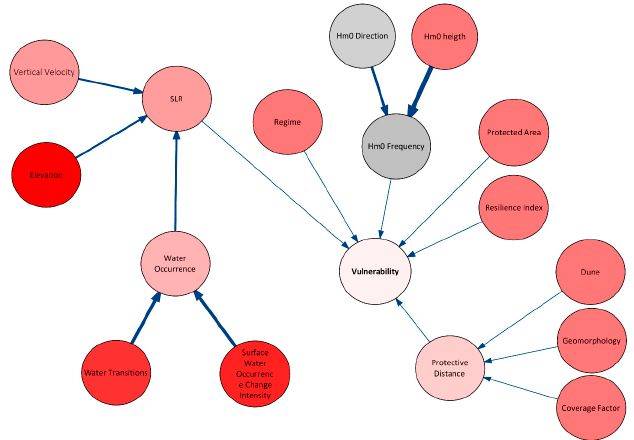
Figure 10. The result of the tests on sensitivity (i.e., from higher sensitivity variables in vivid red to lower sensitivity variables in grey) and strength of influence for a “high vulnerability” state considering the present and highly pessimistic scenarios. The thickness of the arrows indicates the strength of influence between the nodes that they connect (Table S3 in supplementary material). The vivid red variables show the highest impact on the target variable. The paler shades of red show variables with lower influence on the target